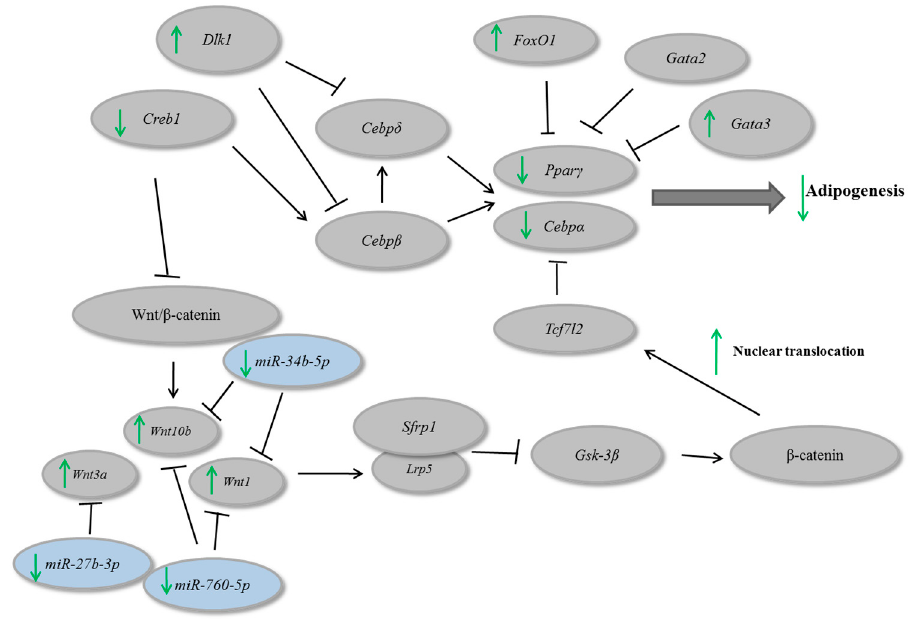
Figure 5. In vitro effects of guarana in gene and microRNAs involved on adipogenesis.